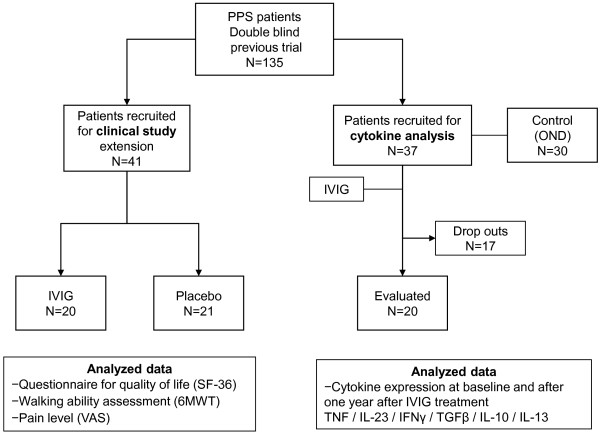
Flow of patients through the study and data available for analysis.